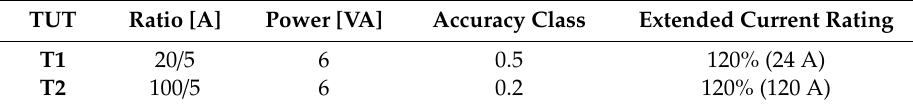
Table 4. Main features of the two transformers under test (TUTs).